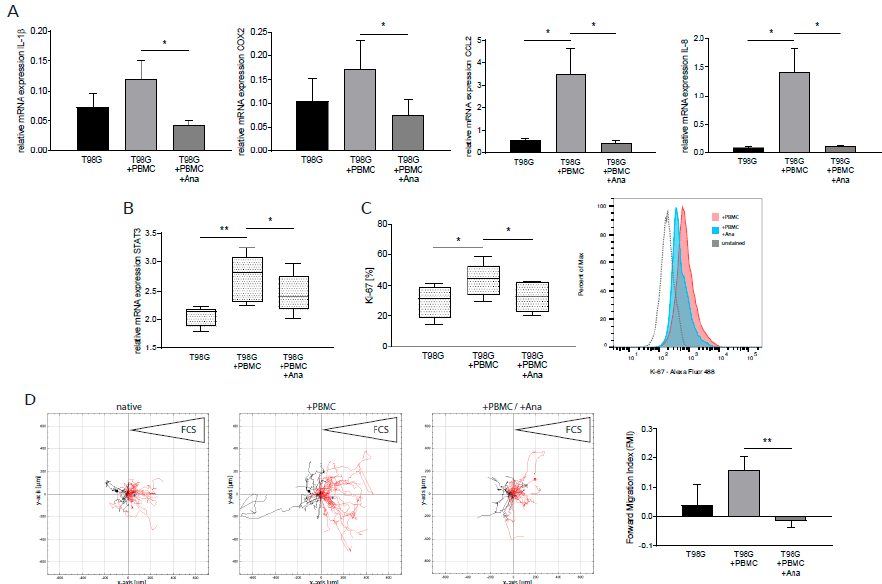
Figure 3. Anakinra inhibited co-culture-induced expression of proinflammatory cytokines and signal transducer and activator of transcription 3 (STAT3) in GBM and inhibits tumor proliferation and migration. T98G cells were indirectly incubated with PBMCs. ( A ) mRNA expression of proinflammatory cytokines in T98G (n = 7, p < 0.040). ( B ) mRNA expression of transcription factor STAT3 in T98G (n = 7, p < 0.016). ( C ) Quantification of Ki-67-positive T98G cells by flow cytometry (n = 6, p < 0.05). One representative histogram is shown. ( D ) Analysis of chemotaxis time-lapse microscopy by single-cell tracking. T98G cells from indirect co-cultures were incubated with FCS as a chemotactic stimulus (right reservoir). At least 40 cells were tracked. One representative example of four independent experiments is shown (left panel, n = 4). Analysis of forward migration index (FMI, coordinate of a cell in the indicated direction (x-axis) divided by the accumulated distance of its paths, representing e ffi ciency of forward migration) (right panel, n = 4, p = 0.008). * p < 0.05, ** p < 0.01. Cancers 2020